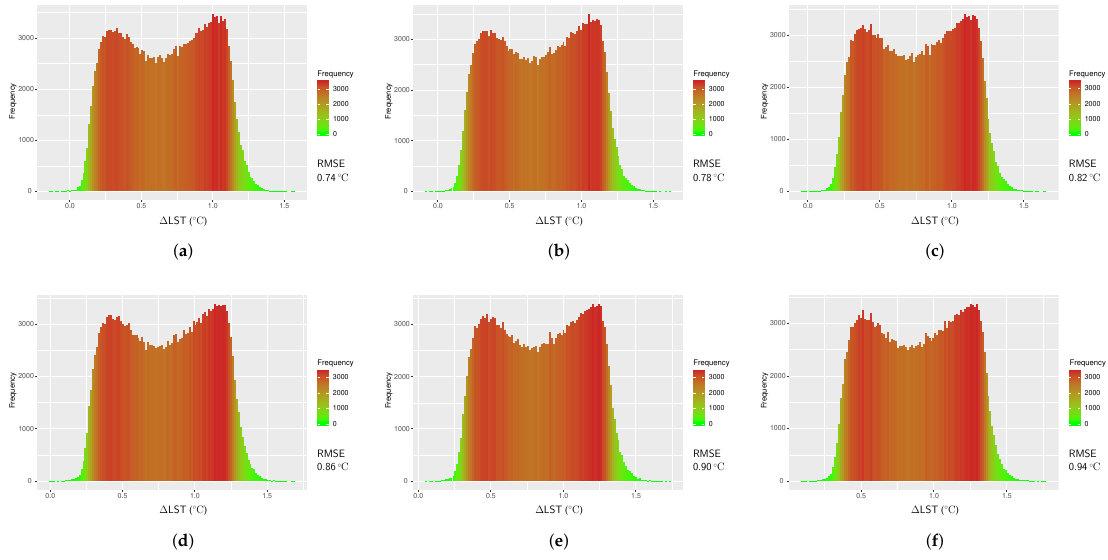
Figure 6. Histograms of temperature difference between the reference LST (LST ref ) and LST from Jiménez-Muñoz et al.’s Split-Window algorithm (LST Jim ) for Landsat 8 image of 21 February 2018; ( a ) w = 0.5gcm − 2 , ( b ) w = 1.0gcm − 2 , ( c ) w = 1.5gcm − 2 , ( d ) w = 2.0gcm − 2 , ( e ) w = 2.5gcm − 2 , and ( f ) w = 3.0gcm − 2